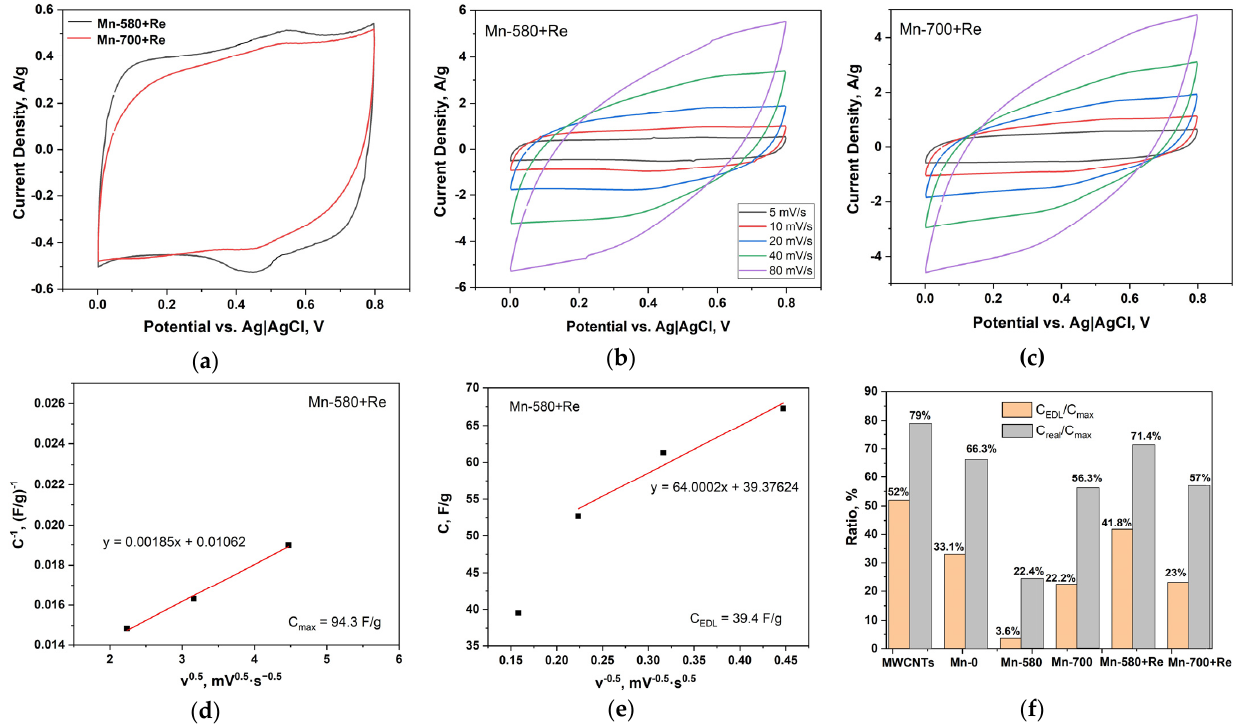
Figure 7. (a) CV curves of electrodes based on Mn-580+Re and Mn-700+Re, measured at a potential scan rate of 5 mV/s; CV curves measured at different potential scan rates for electrodes based on (b) Mn-580+Re and (c) Mn-700+Re; (d) the dependence of the reciprocal of the total capacitance (C -1 , (F/g) -1 ) on the square root of the scan rate (v 0.5 , mV 0.5 ·s − 0.5 ) and (e) the total capacitance (C, F/g) on the reciprocal of the square root of the scan rate (v − 0.5 , mV − 0.5 ·s 0.5 ) for the Mn-580+Re electrode; (f) the